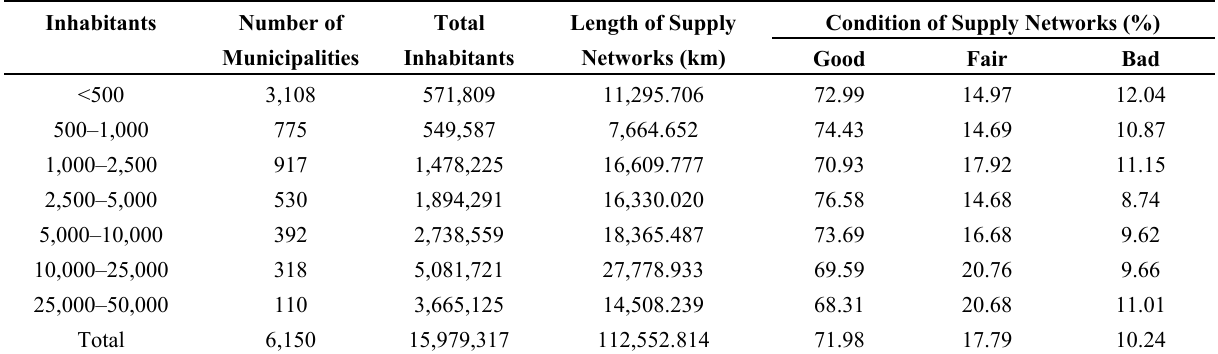
Table 3. Condition of water supply networks in Spanish municipalities with fewer than 50,000 inhabitants (2012) a